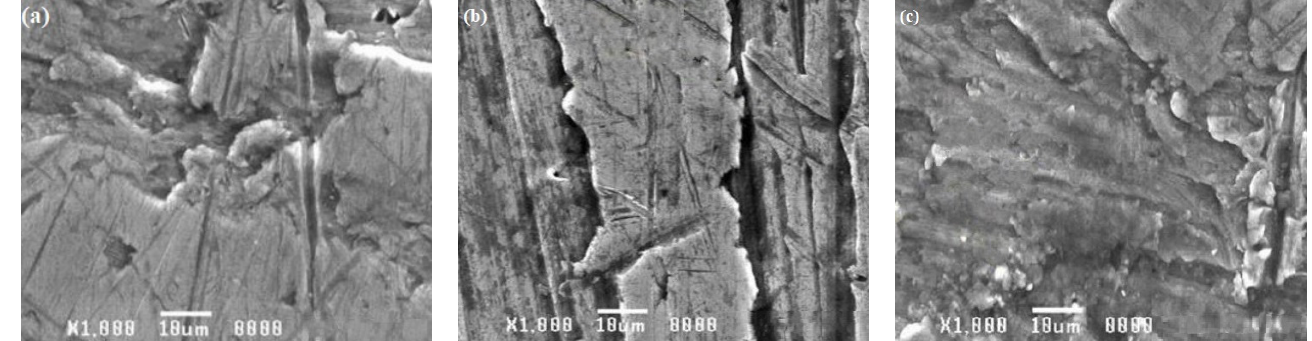
Figure 13. SEM images of ( a ) AA6061, ( b ) AA8011, ( c ) and weld region specimens after submersion testing in H 2 SO 4 .